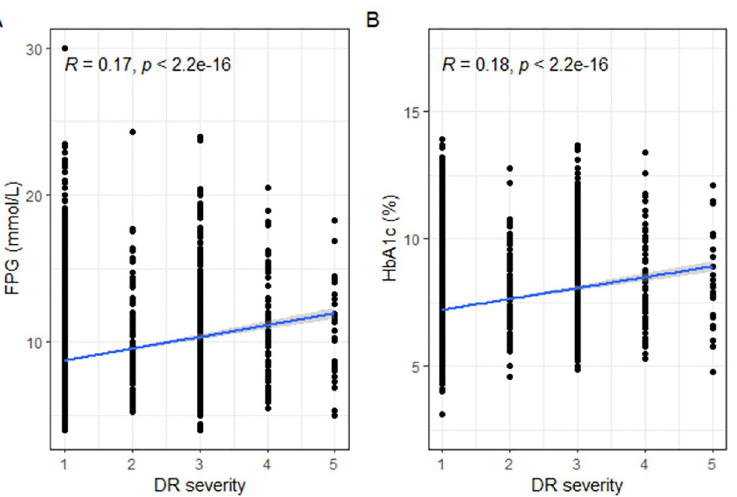
Fig 2. Spearman correlation analysis results about the correlation between FPG (A)/ HbA1c (B) and the intensity of fundus degeneration. R, correlation value by Spearman correlation analysis; P, significance level in Spearman correlation analysis. Abbreviations: DR, diabetic retinopathy; DR severity: 1(NDR, no diabetic retinopathy), 2(Mild NPDR, mild non-proliferative diabetic retinopathy), 3(Moderate NPDR), 4(Severe NPDR), 5(PDR, proliferative diabetic retinopathy); FPG, fasting plasma glucose; HbA1c, glycated hemoglobin